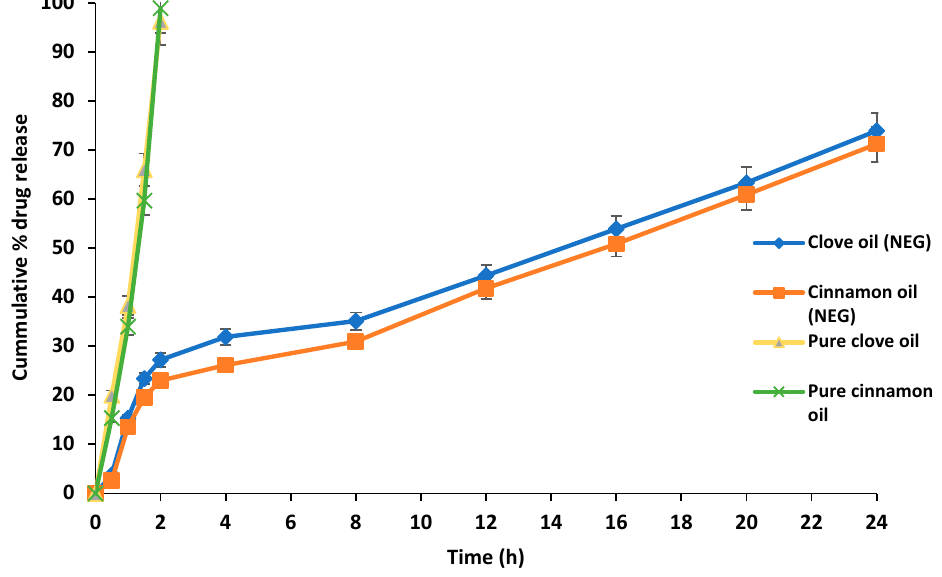
Figure 5. The release of cinnamaldehyde essential oil and clove essential oil from the optimized nanoemulgel formulation.